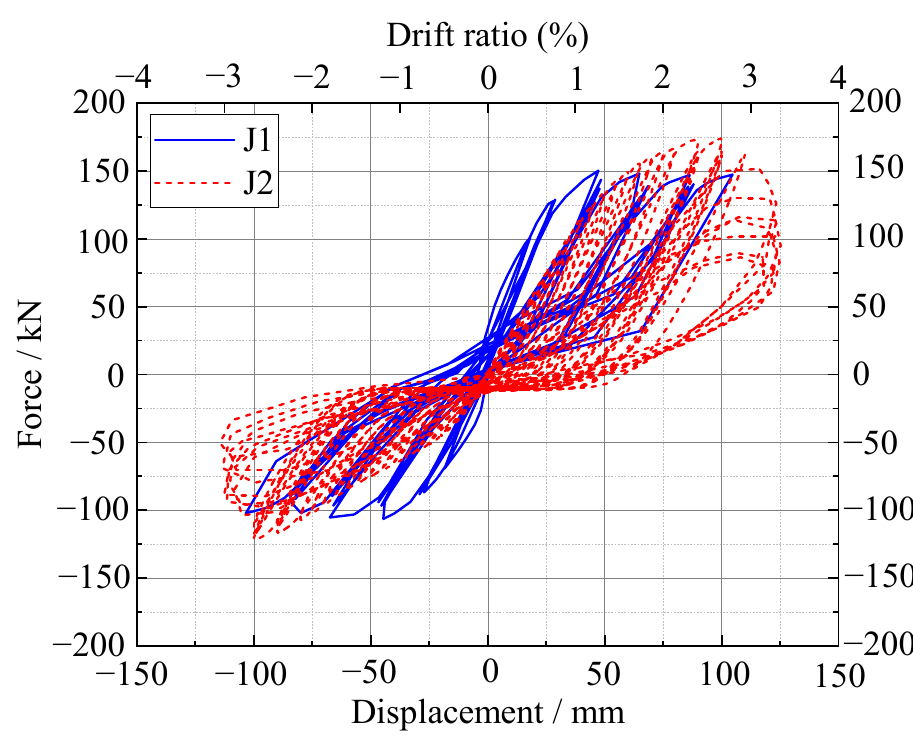
Figure 15. Comparison of experimental and simulated curves.